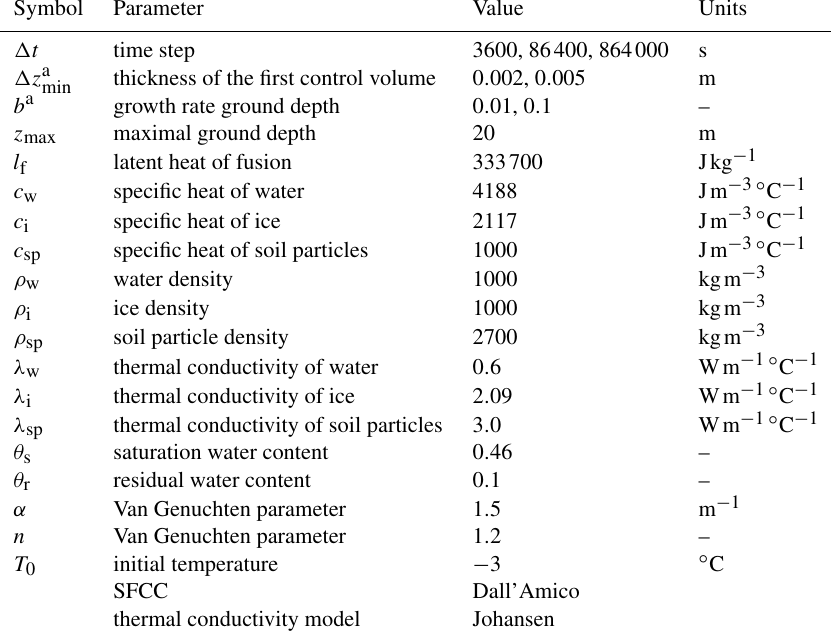
Table G1. Input parameters for the numerical tests.